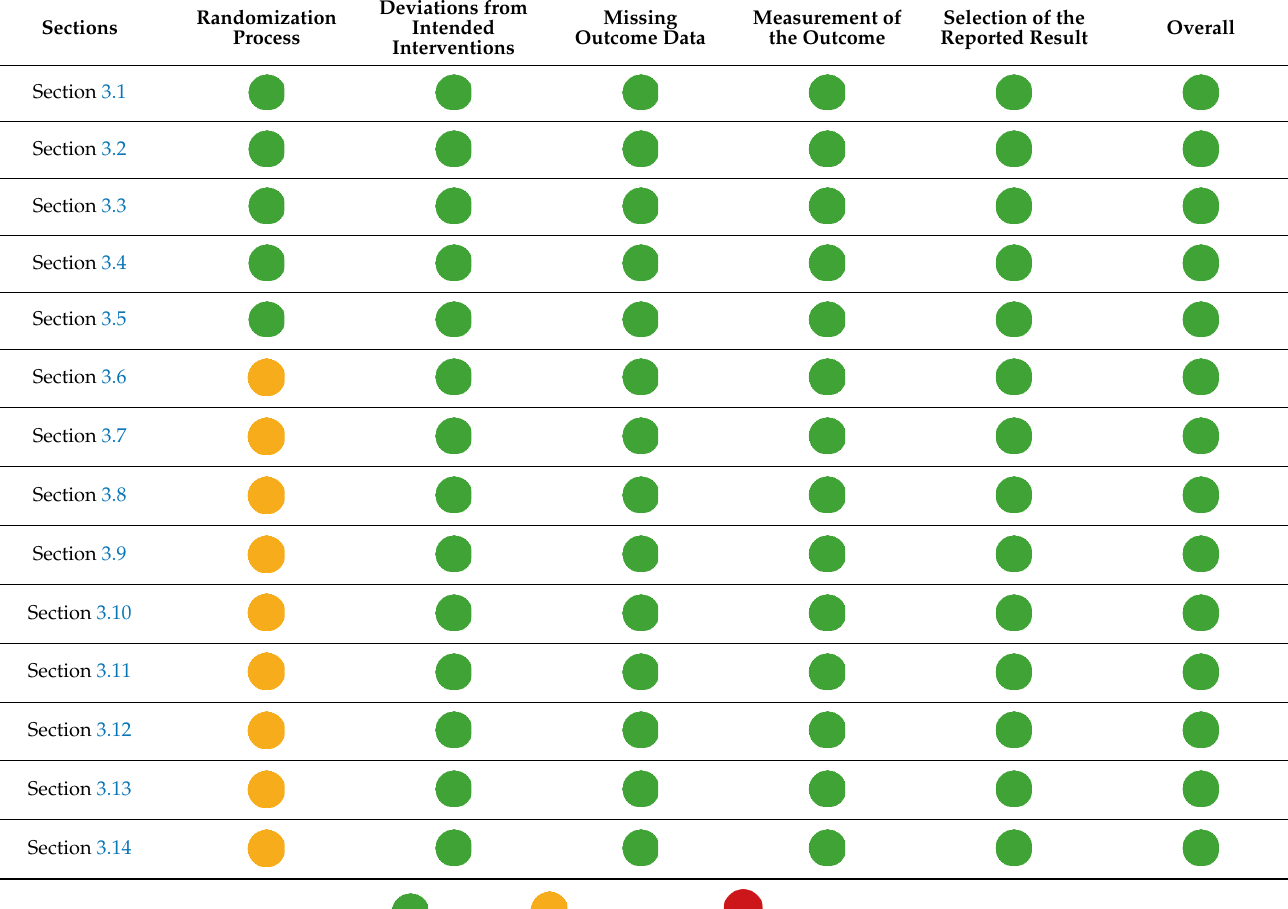
Table 1. Cochrane risk of bias tool for randomized trials, version 2 (RoB 2).